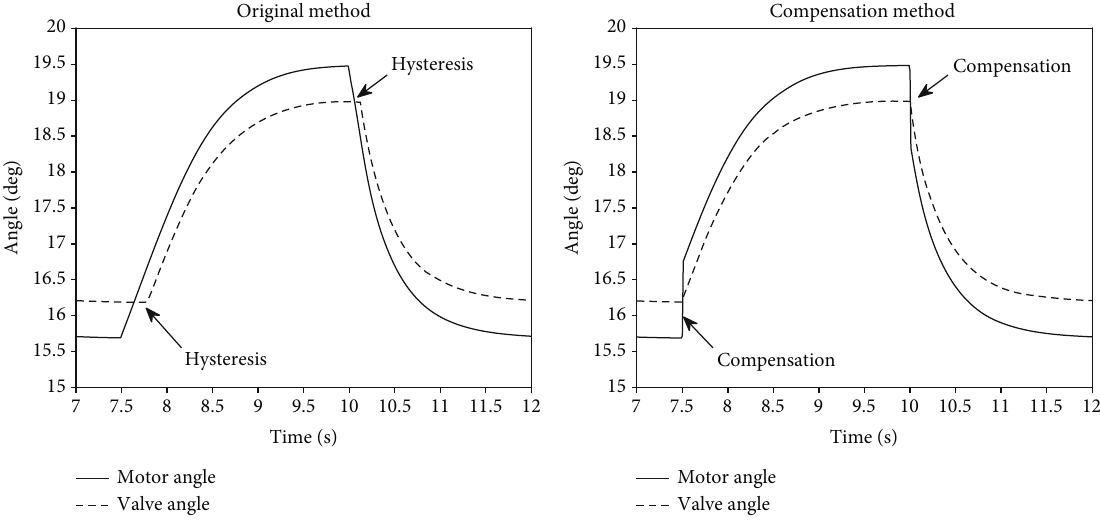
Figure 14: Result of motor angle and valve angle by a constant compensation